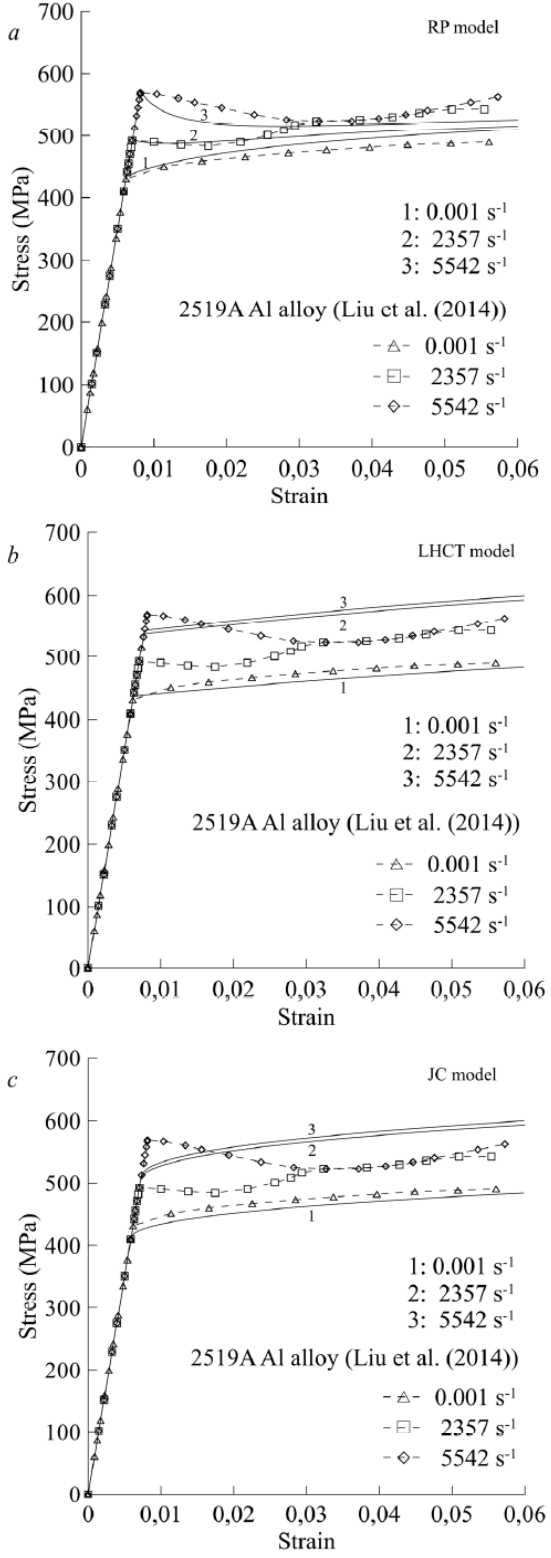
Fig. 7. Stress-strain relationships of aluminum al- loy 2519 A (data from [55]), plotted by RP model (a), LHCT model (b) and JC model